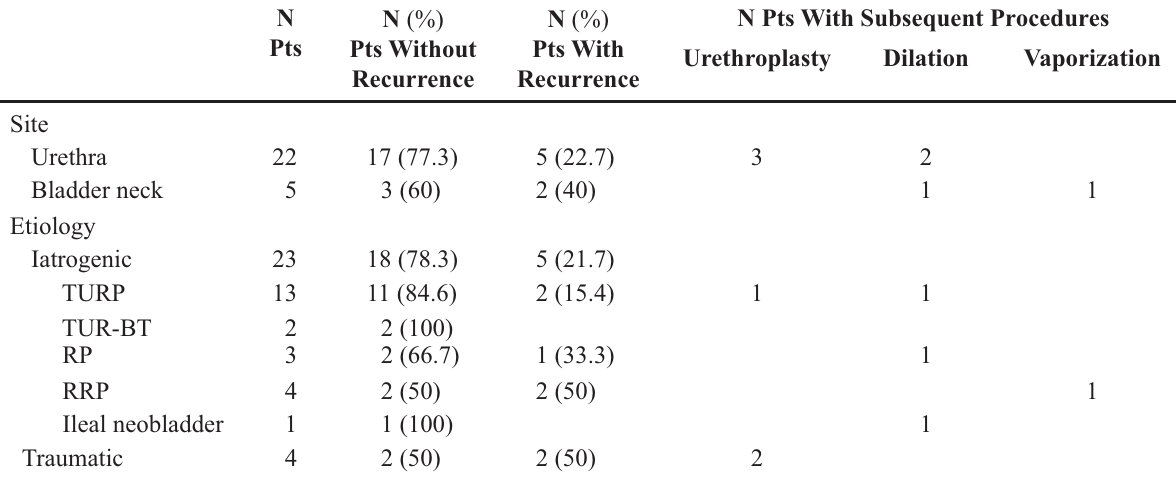
Table 3 – Outcome of bipolar vaporization and subsequent